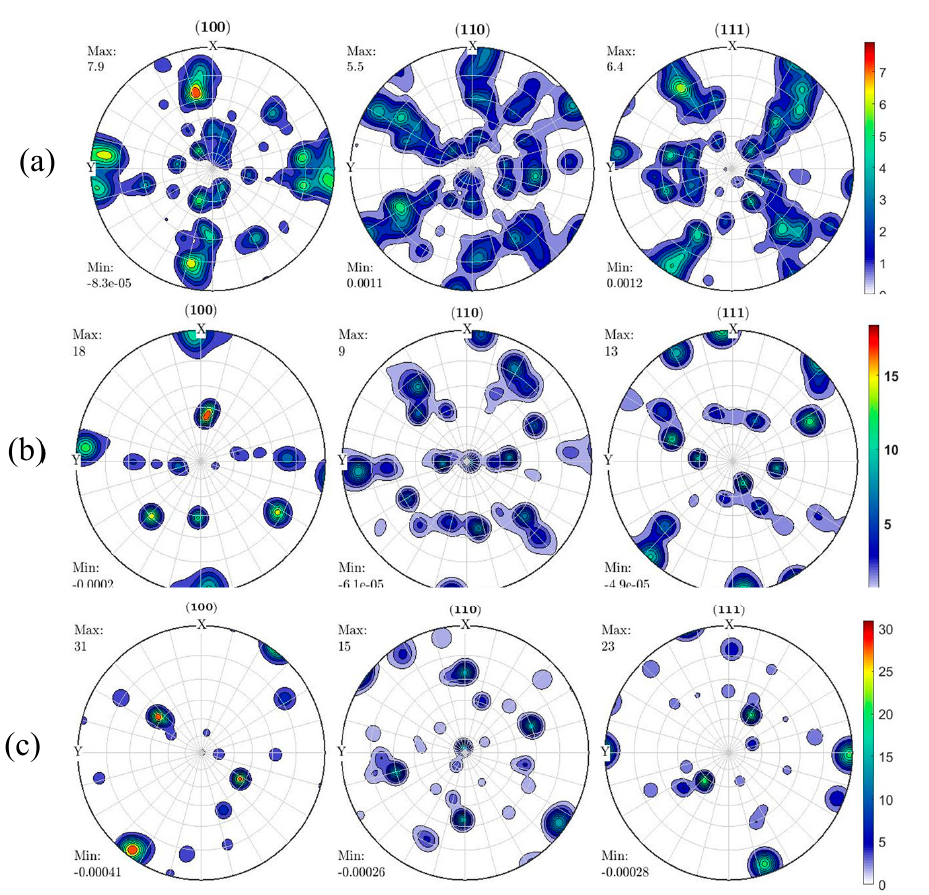
Figure 11. The (100), (110), and (111) pole figures of the reconstructed β -phase of ( a ) samples A, ( b ) samples B, and ( c ) samples C.